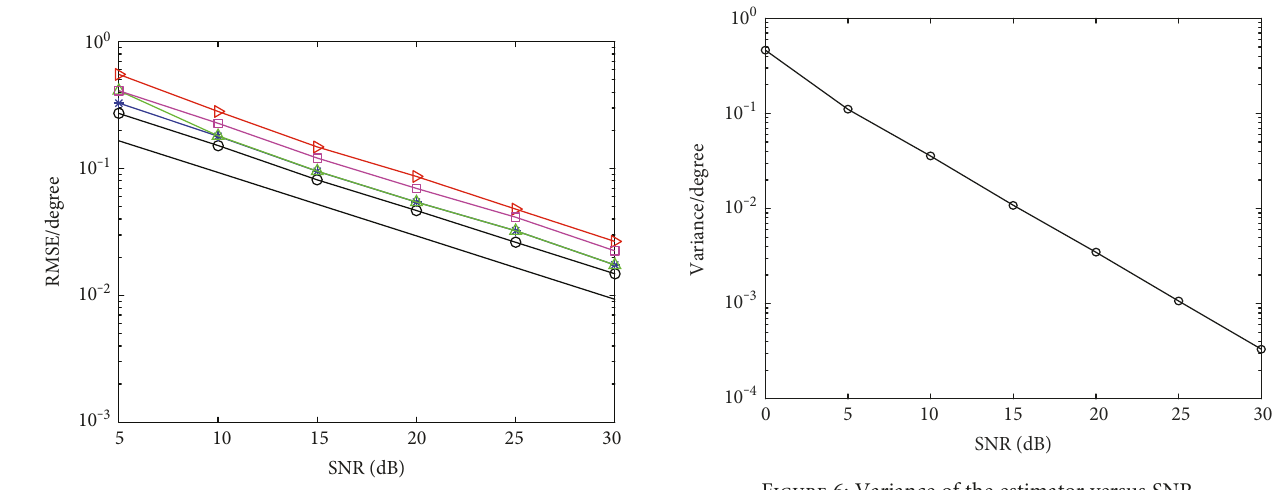
Figure 6: Variance of the estimator versus SNR.